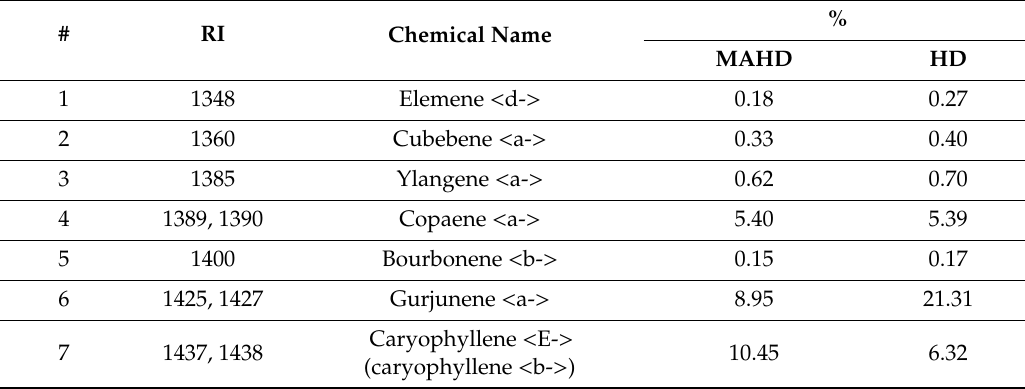
Figure 4. Optimal conditions by solution of ramps. Table 5. The chemical contents of Callicarpa candicans essential oil obtained by microwave-assisted hydro-distillation (MAHD). RI: retention time indices (RI); HD: